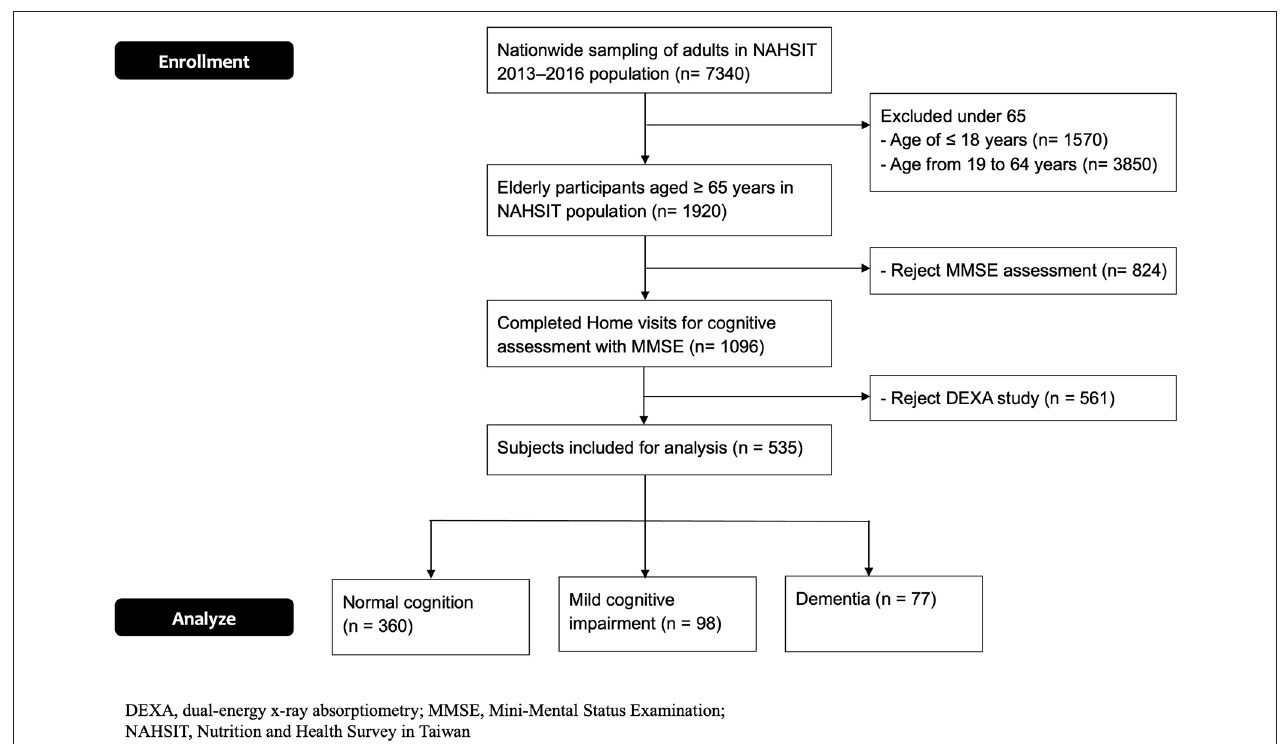
FIGURE 2 | Flowchart of the